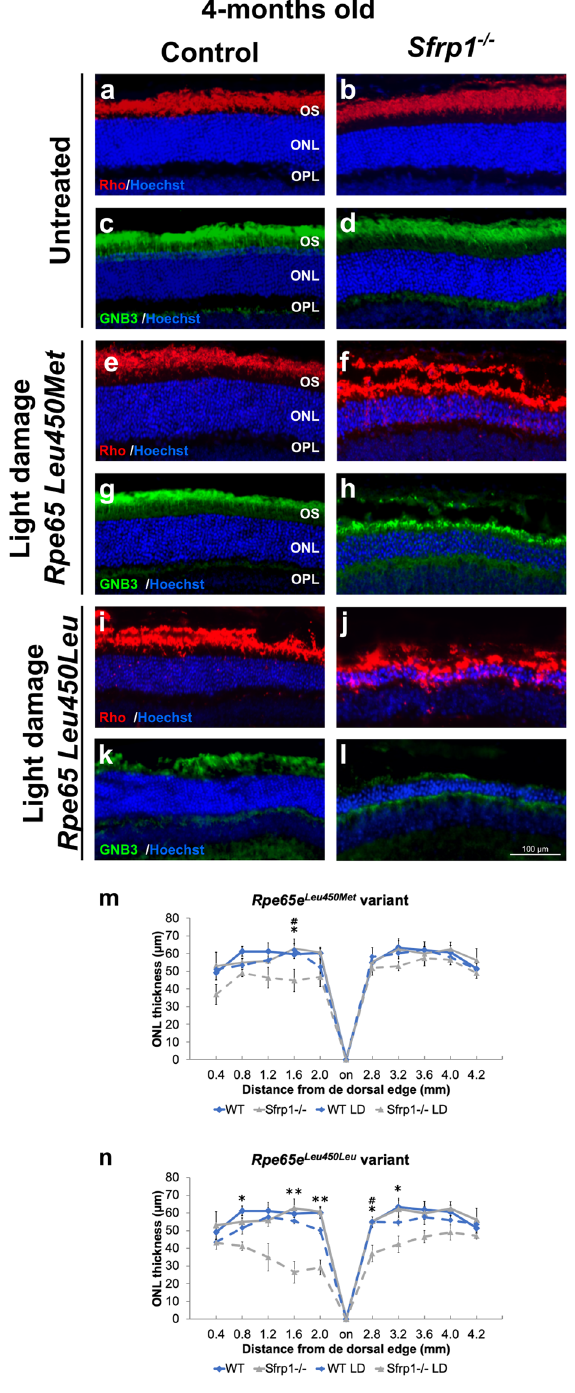
Figure 6. Sfrp1 − / − retinas are more prone to light-induced damage even in the presence of the Rpe65 Leu450Met protective variant. ( a – l ) Frontal cryostat sections from 4 months-old control and Sfrp1 − / − retinas carrying the Rpe65 Leu450Leu or the protective Rpe65e Leu450Met variants before and 7 days after light induced-damage (light conditions: 15000 lux of cool white fluorescent light for 8 hrs). Sections were immunostained with antibodies against Rho (rods, red) or GNB3 (cones, green) and counterstained with Hoechst. ( m , n) The graphs represent the ONL thickness (measures were taken in cryostat frontal sections of the eye at the level of the optic disk) in the different conditions. Kruskal Wallis with post hoc Dunn. * Indicates significant differences between Sfrp1 − / − untreated and light-damage mice. # Indicates significant difference between Sfrp1 − / − and wt animals exposed to light damage. No significant differences were found between wt untreated and light-damage mice. * p < 0.05, ** p < 0.01. Scale bar in l applies to all panels. Abbreviations: ONL: outer nuclear layer; OPL: outer plexiform layer; OS outer